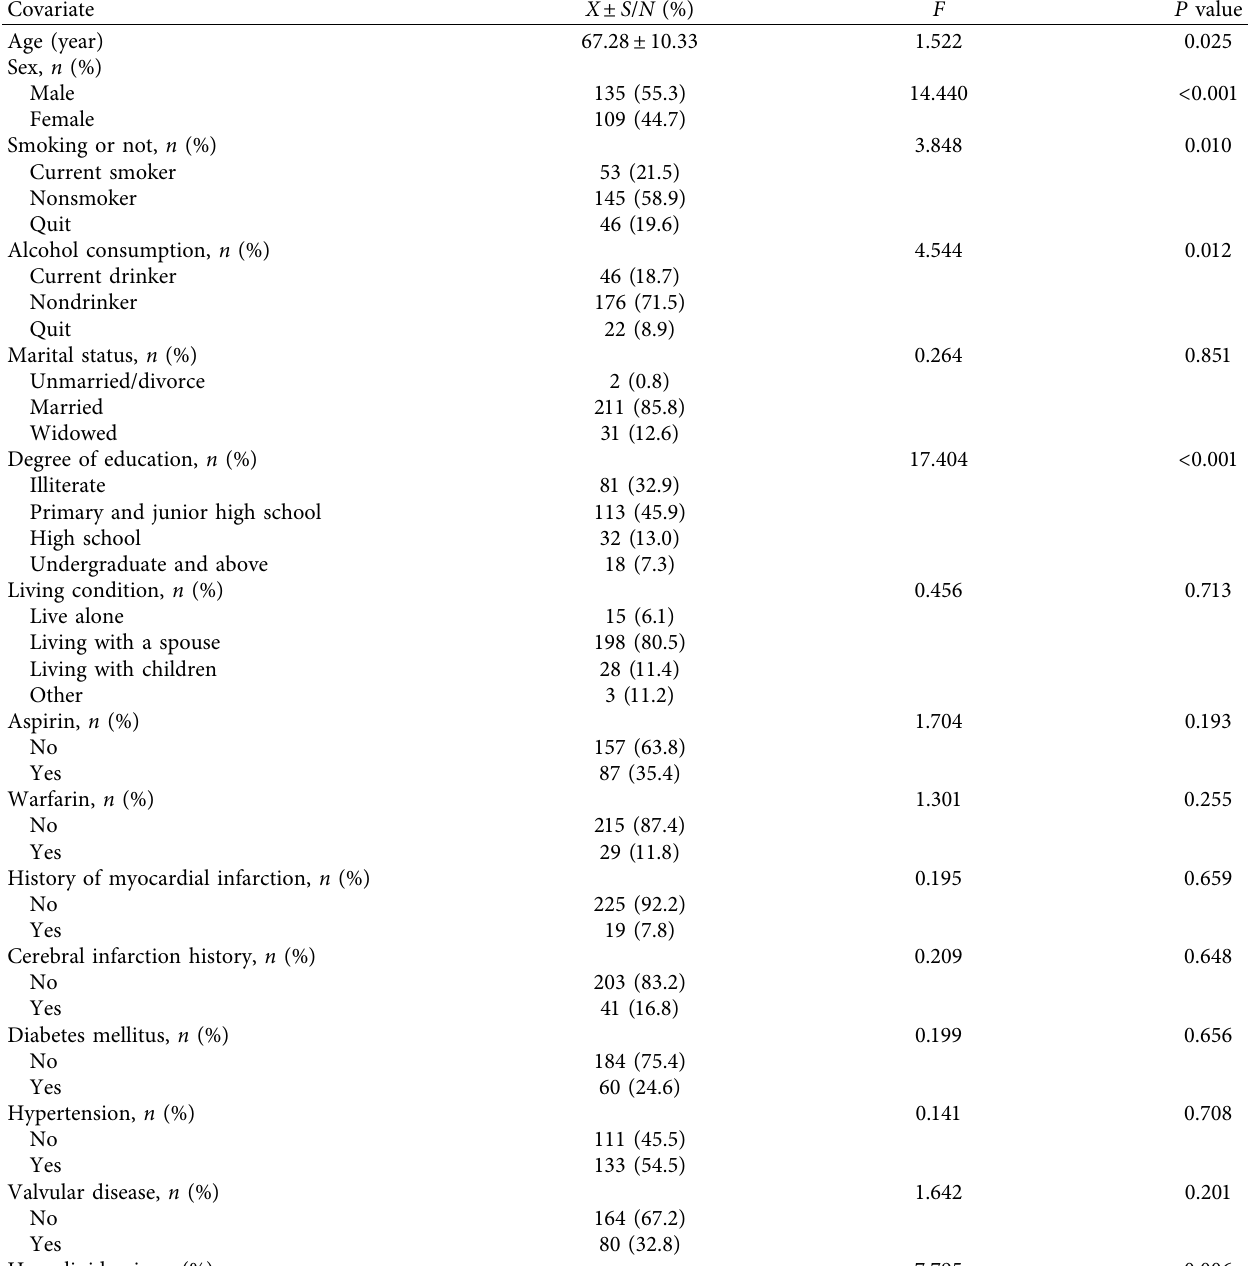
Table 2: Univariate analysis of cognitive dysfunction in patients with atrial